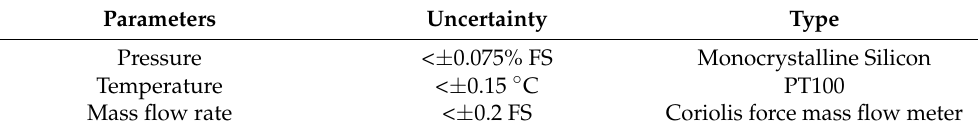
Table 4. Measurement parameters.